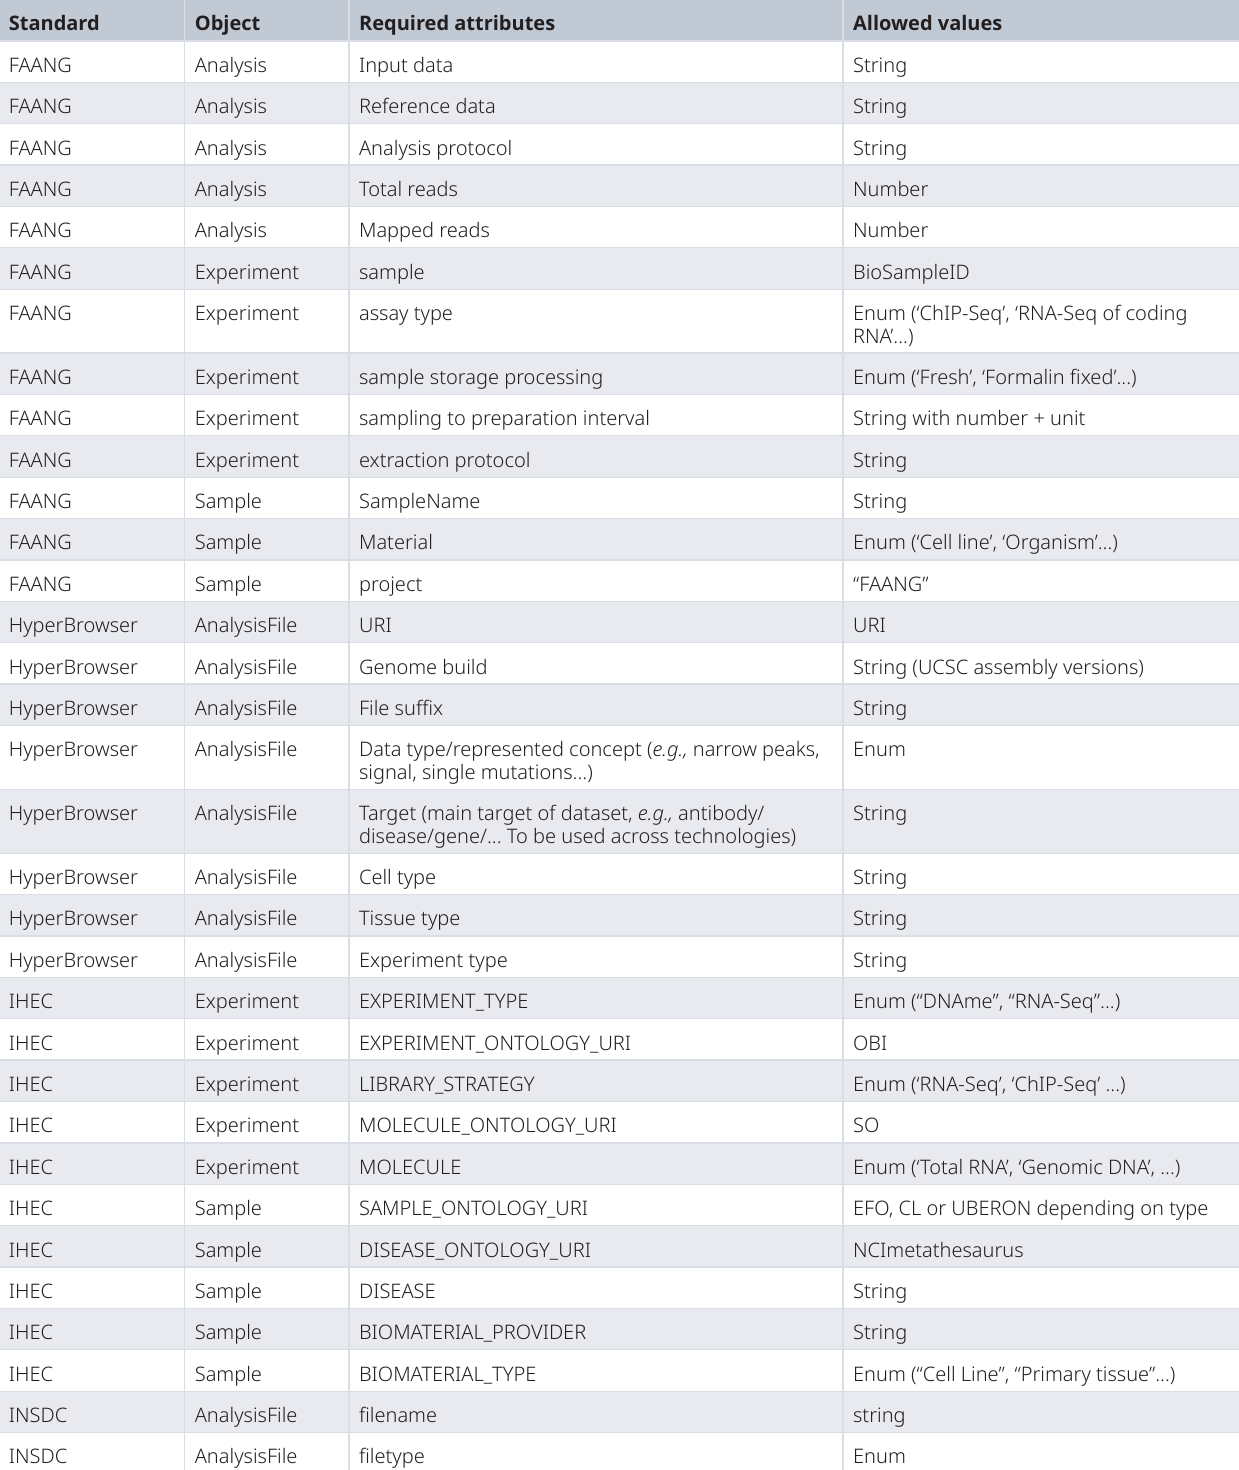
Table 1. Summary of required attributes for metadata standards related to genomic track